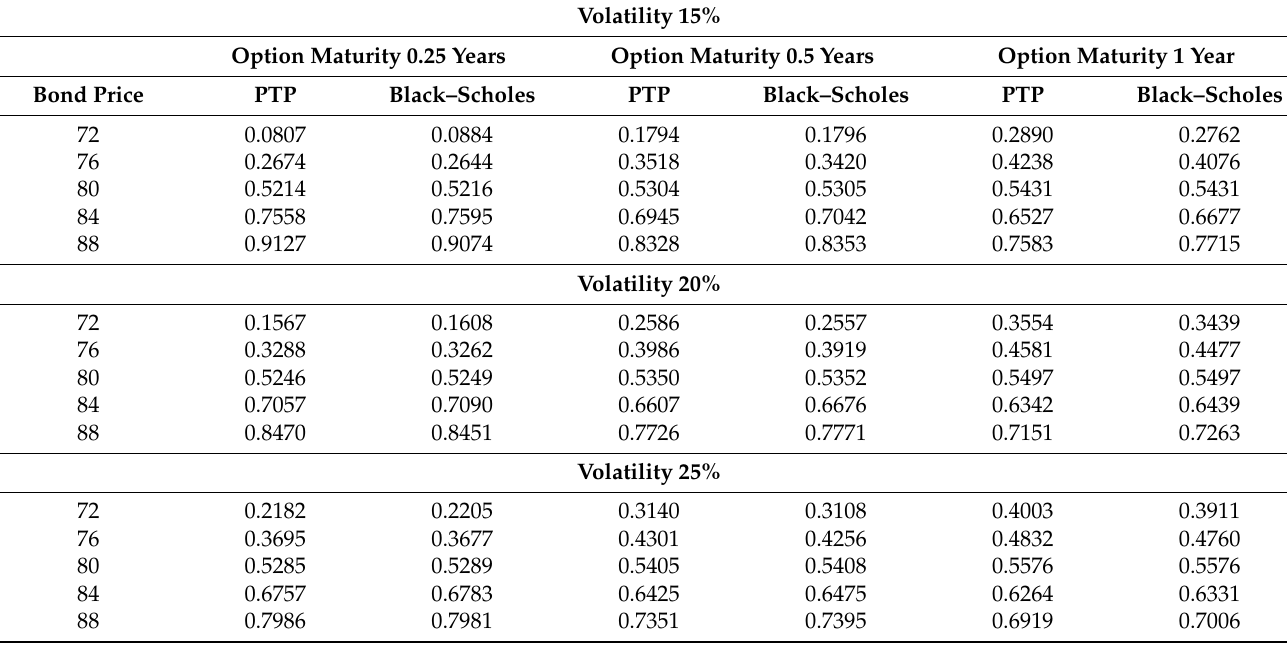
Table 3. Comparison of PTP deltas to Black–Scholes: strike price 80, risk-free rate 0.5%, bond maturity 20 years.